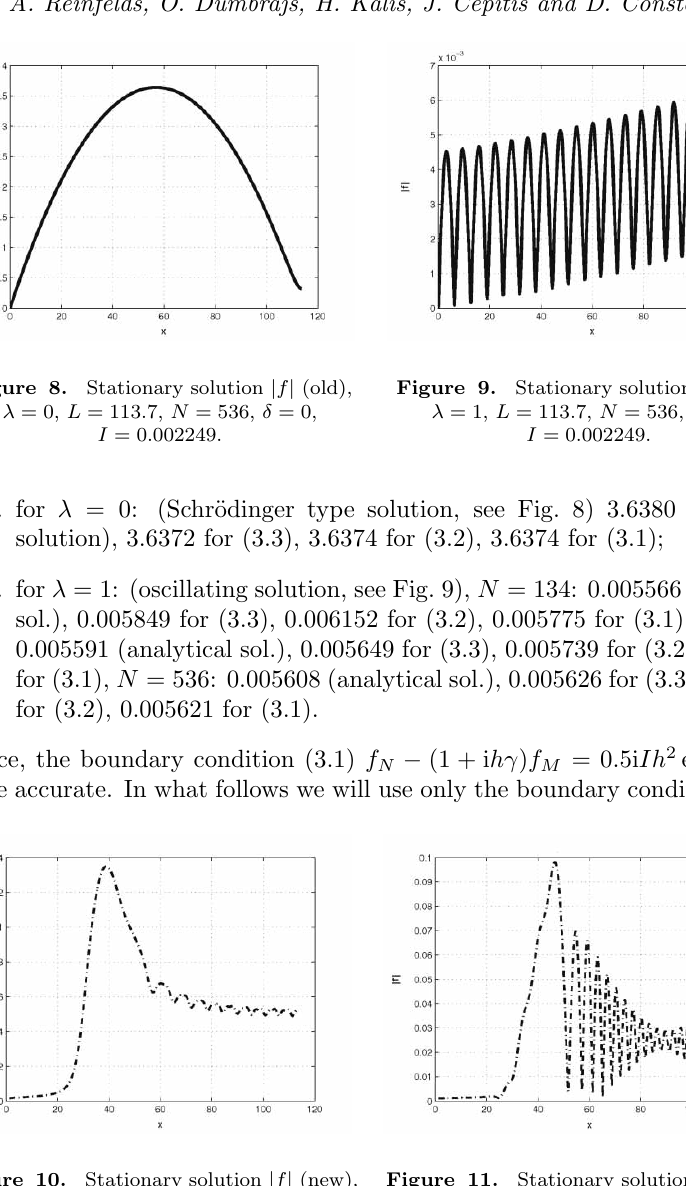
Figure 11. Stationary solution | f | (new), λ = 1, L = 113 . 7, N =